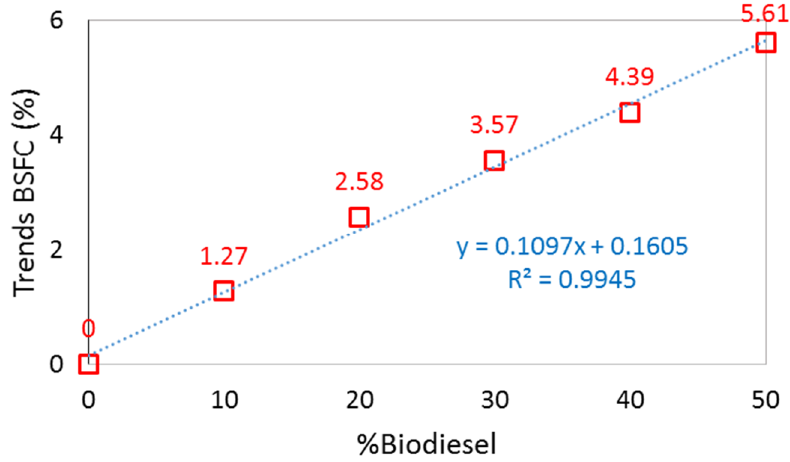
Figure 6. Trending Engine BSFC follows biodiesel blends.